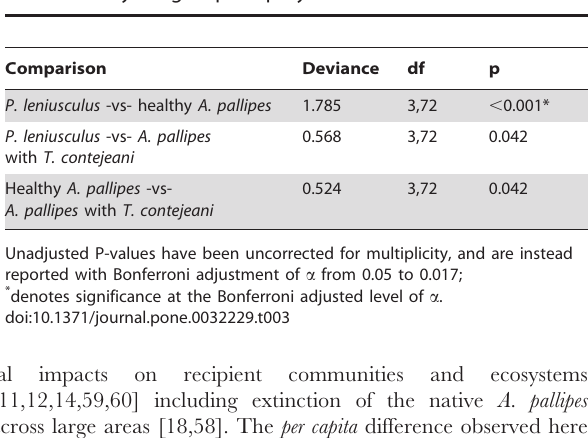
Table 3. Pairwise generalised linear model comparisons between crayfish groups in prey choice for mobile food items.